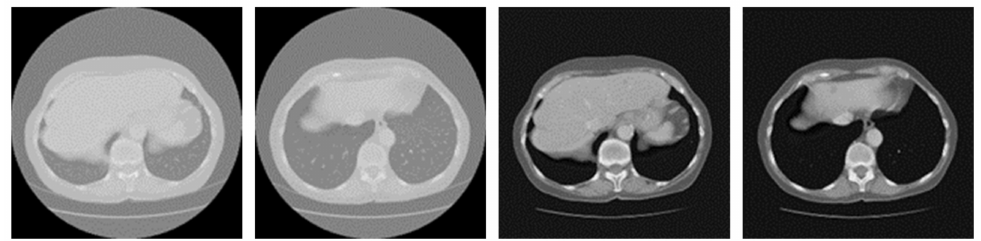
Figure 5. Comparison of the original images and the processed